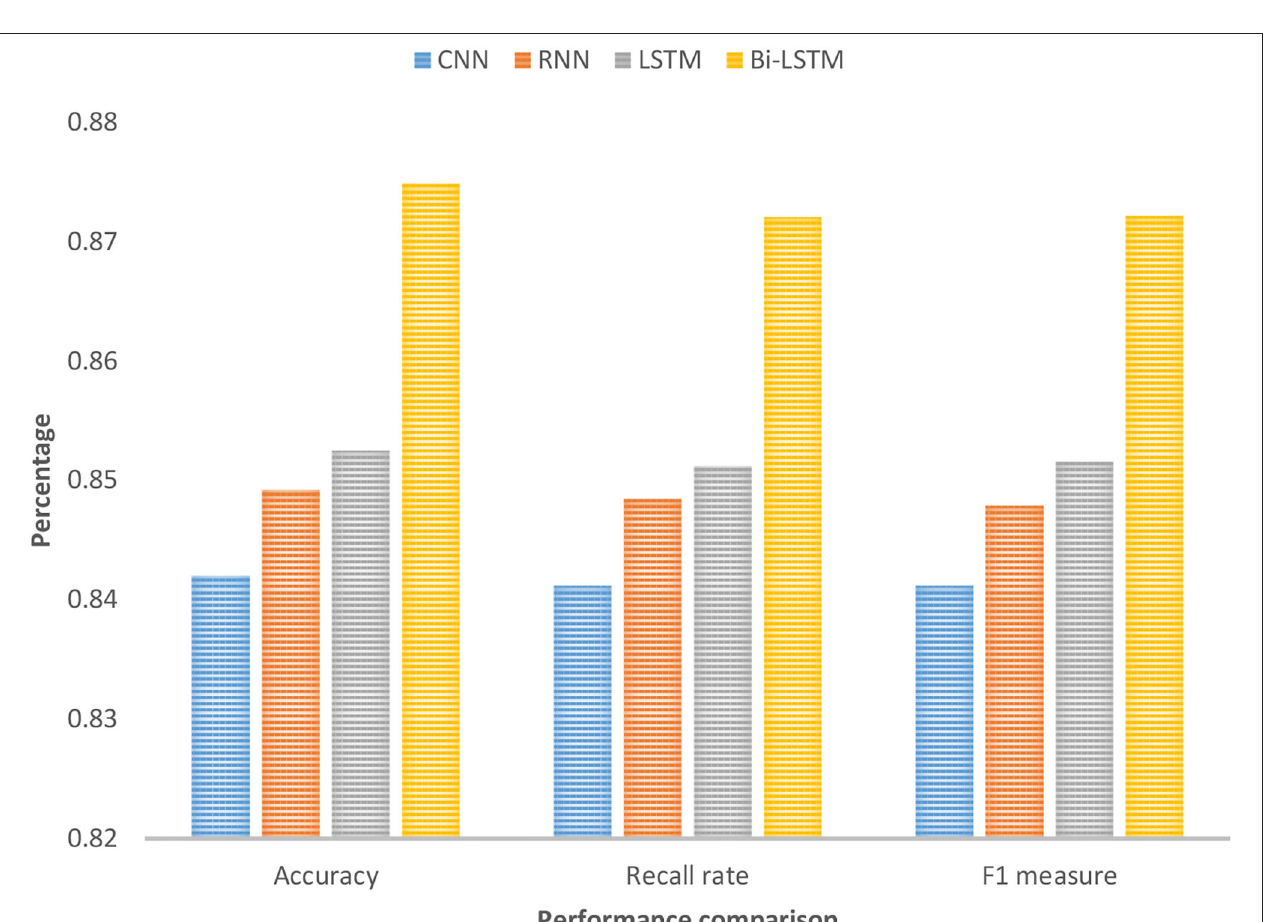
FIGURE 5 | Performance comparison of classification